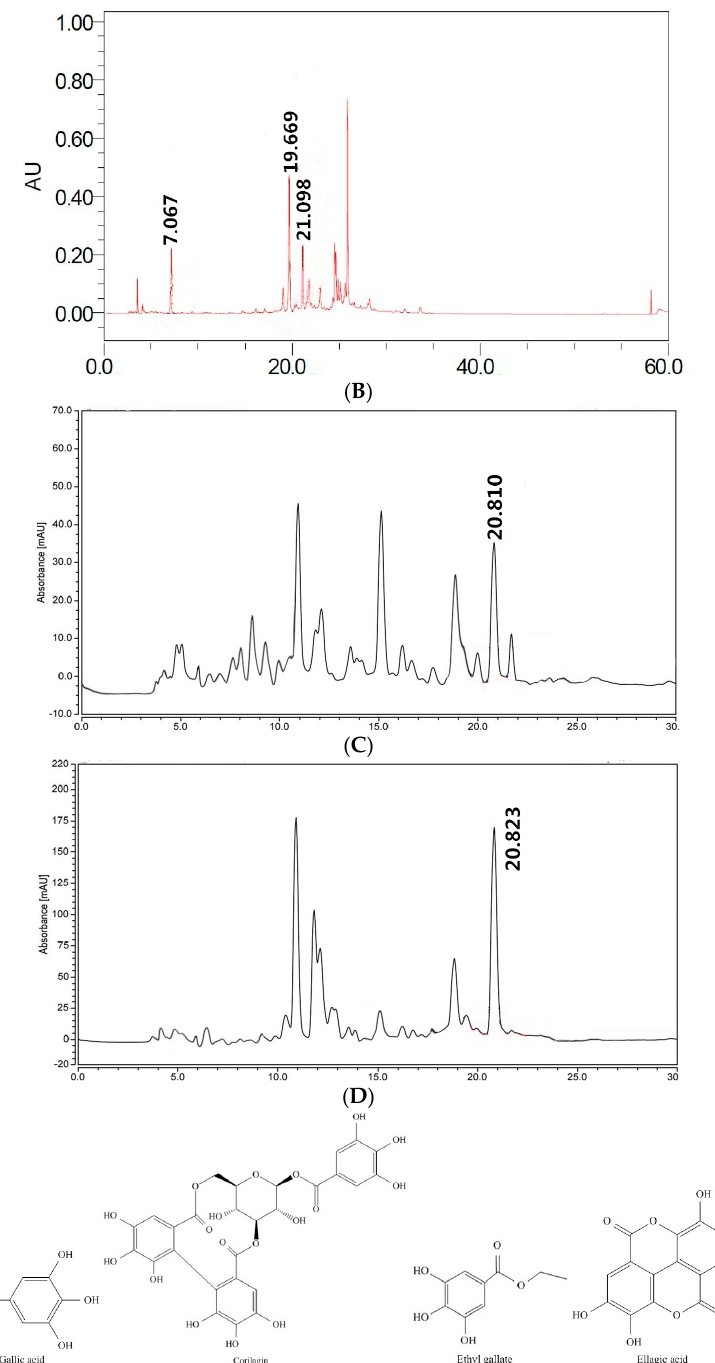
Figure 1. HPLC chromatograms and chemical structures of gallic acid, corilagin and ethyl gallate in longan pericarp extracts ( A ) and longan seed extracts ( B ) detecting at 270 nm; HPLC chromatograms and chemical structure of ellagic acid in longan pericarp extracts ( C ) and longan seed extracts ( D ) detecting at 260 nm. Table 2. Quantification of polyphenolic compounds in longan byproducts by HPLC analysis.